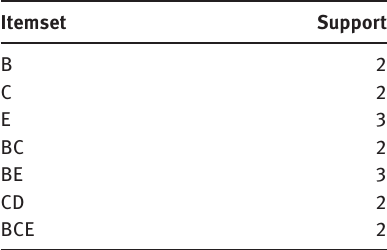
Table 6: Incremental Frequent Itemsets L